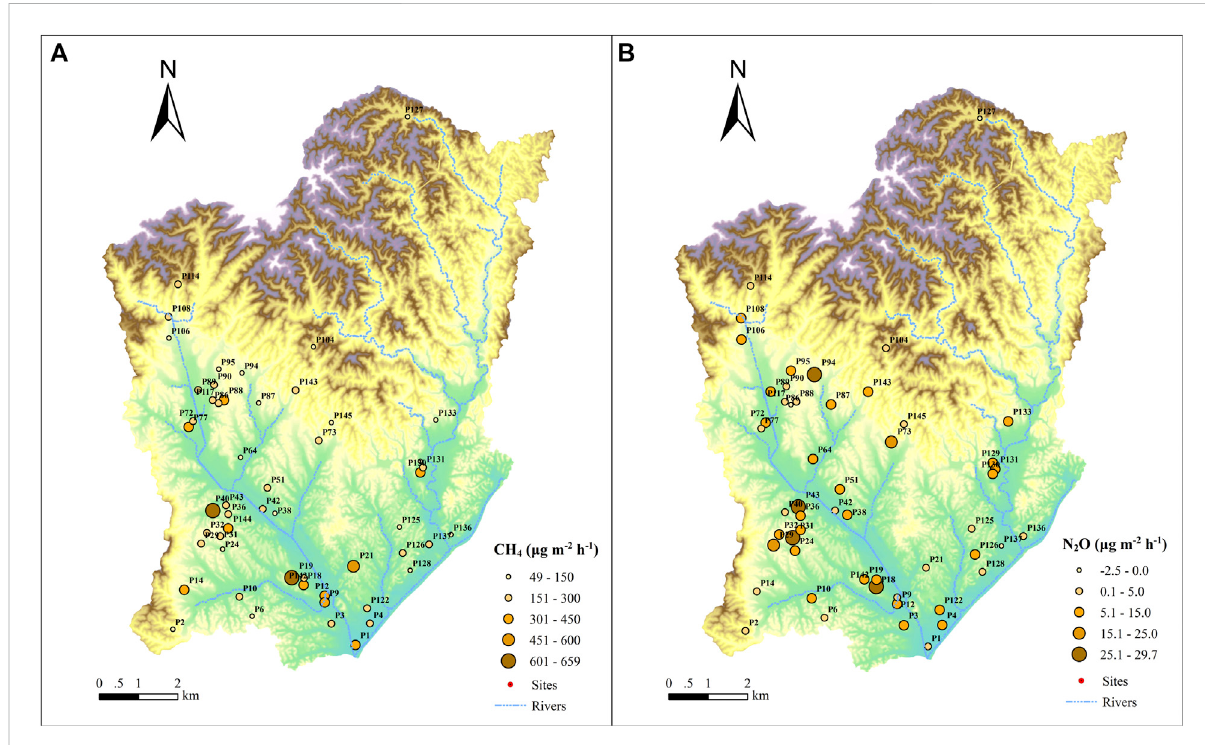
FIGURE 2 Spatial variation of CH 4 (A) and N 2 O (B) fl uxes in the studied